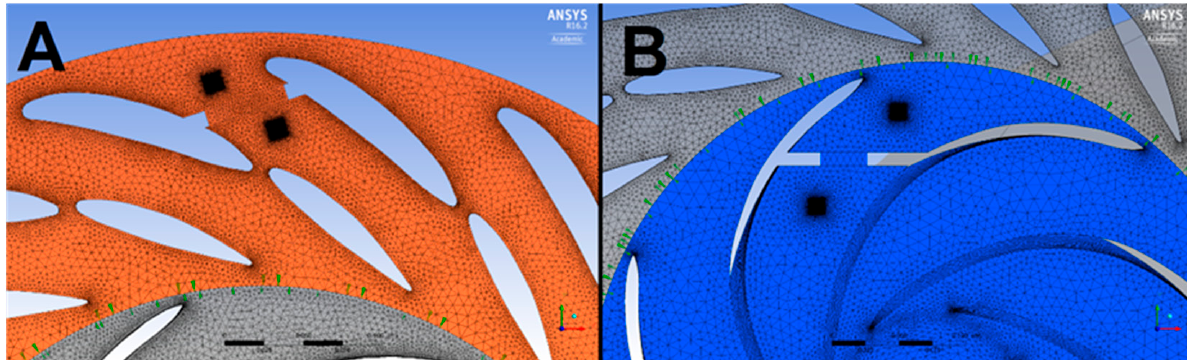
Figure 3. Detail of the geometrical model and computational mesh for the studied cases: ( A ) distributor channel blockage and ( B ) rotor channel blockage.